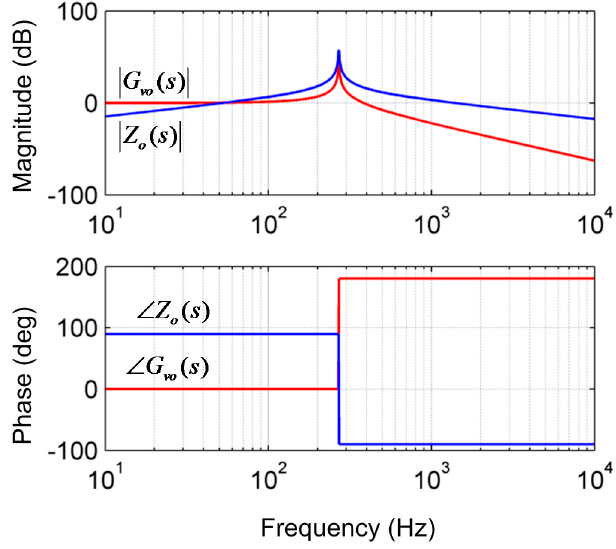
Figure 2. Frequency responses of G vo ( s ) and Z o ( s ).